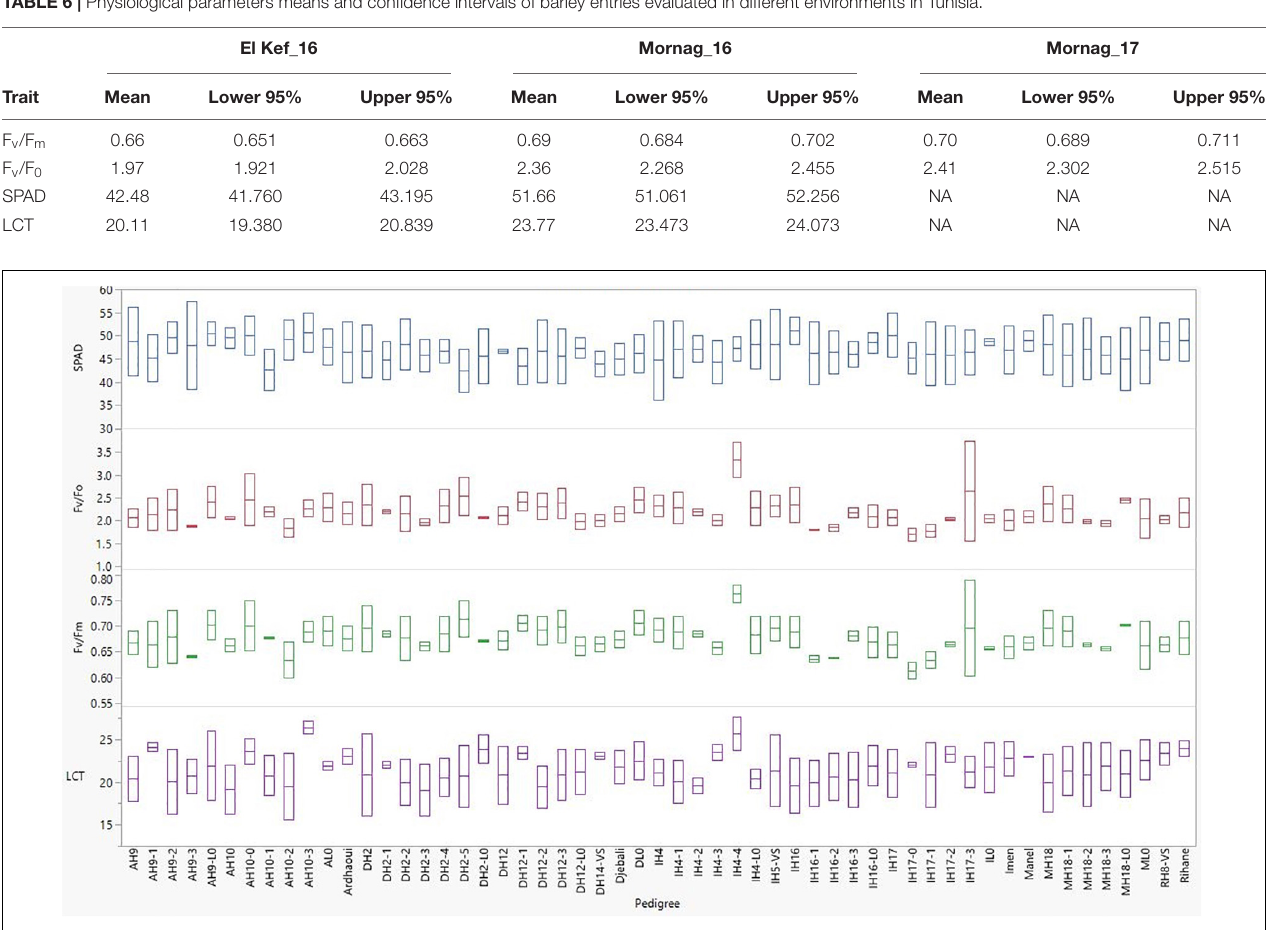
TABLE 7 | Genotypic and environmental effects and their interaction on the grain quality parameters of barley lines selected under ultra-low density when evaluated under dense stand trials in different environments in Tunisia. Source of variation